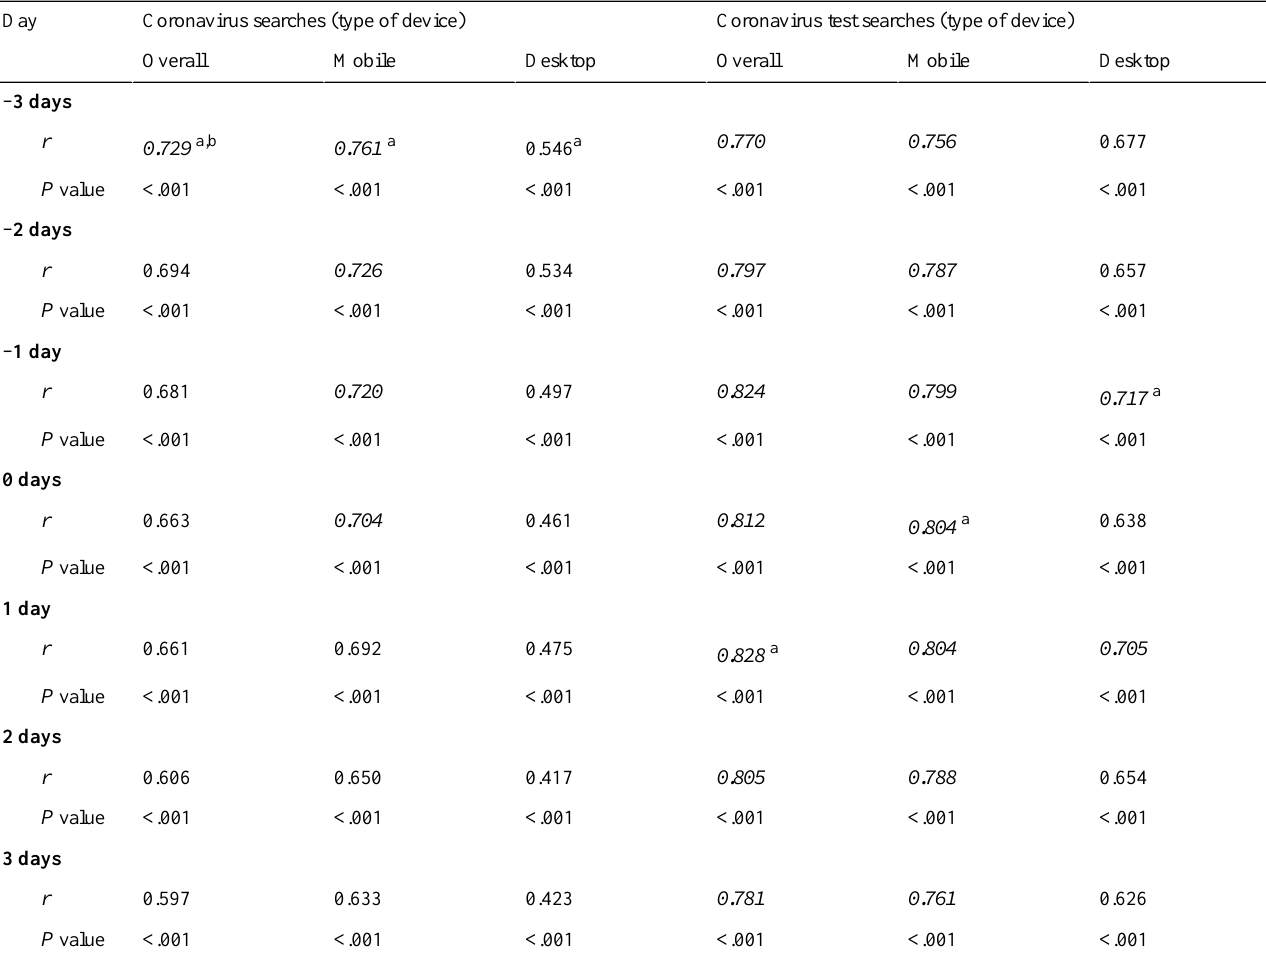
Table 3. Time-lag correlation coefficients between new COVID-19 cases and NAVER relative search volumes related to the coronavirus and coronavirus test in South